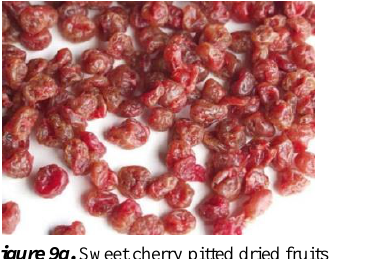
Figure 9a. Sweet cherry pitted dried fruits